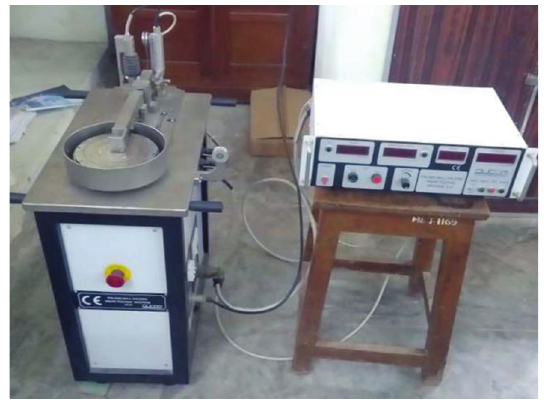
Figure 7: Pin-on-disc tribometer